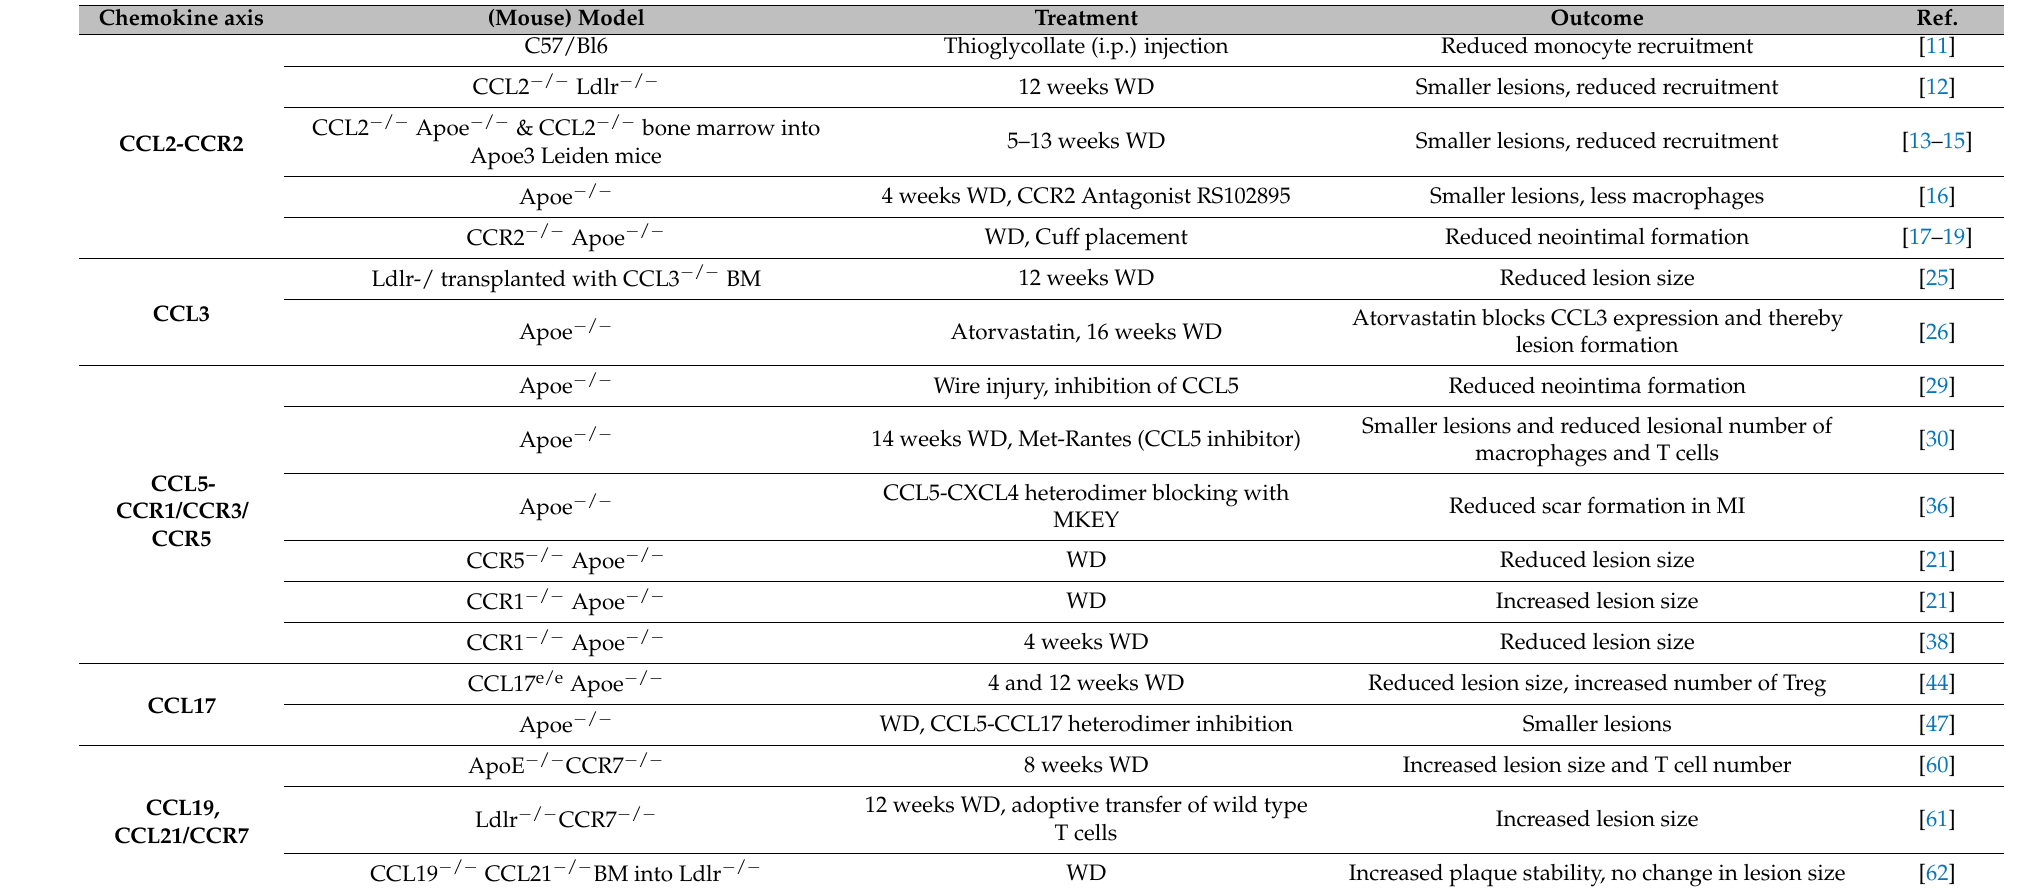
Table 1. Overview of the inflammatory chemokines and their role in murine